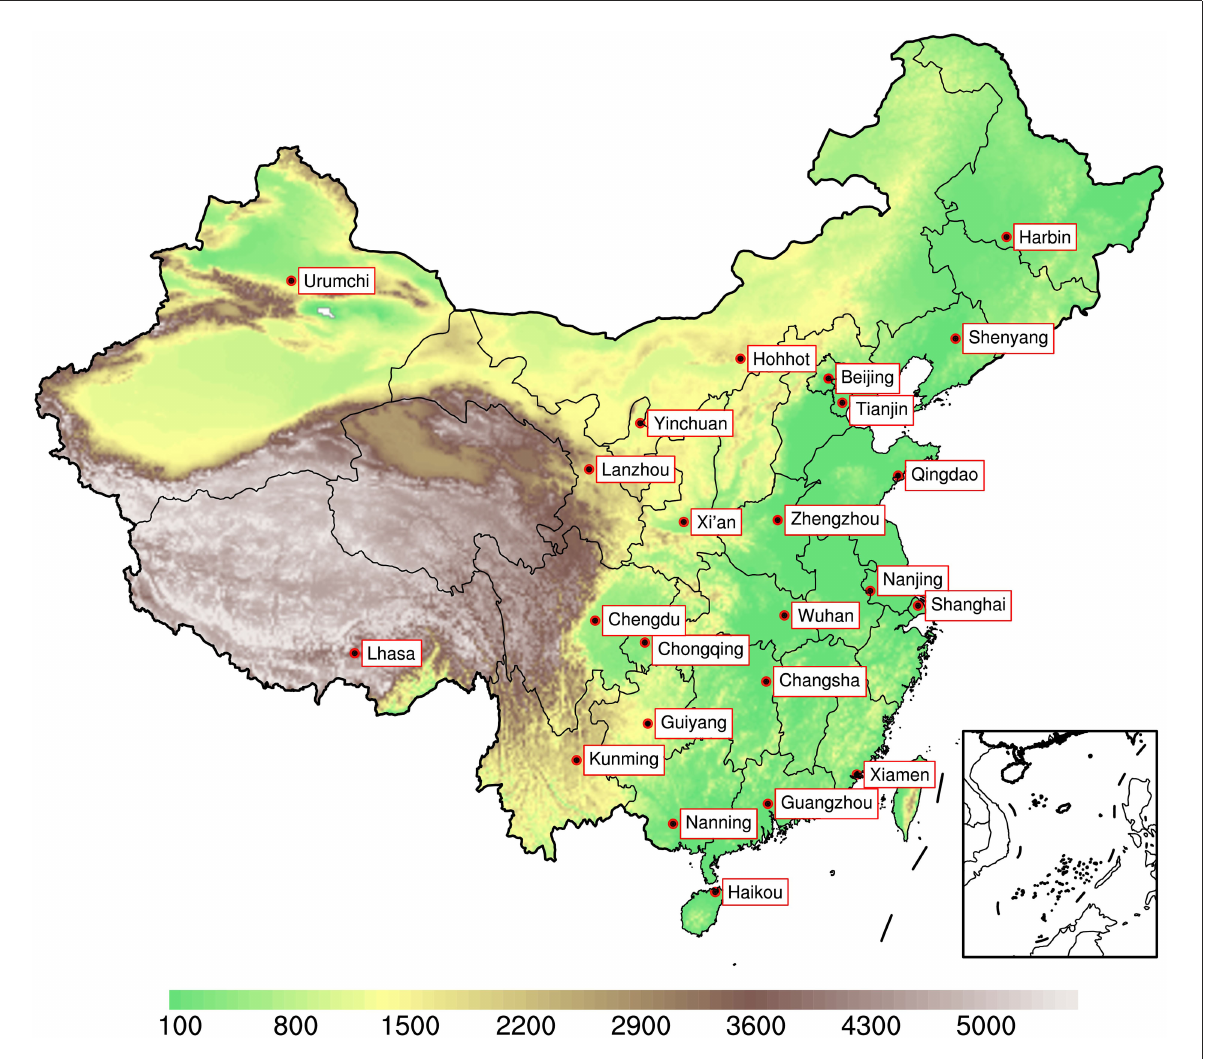
FIGURE1 Locations of selected airports in this study. Shaded areas indicate the orography in meters above sea